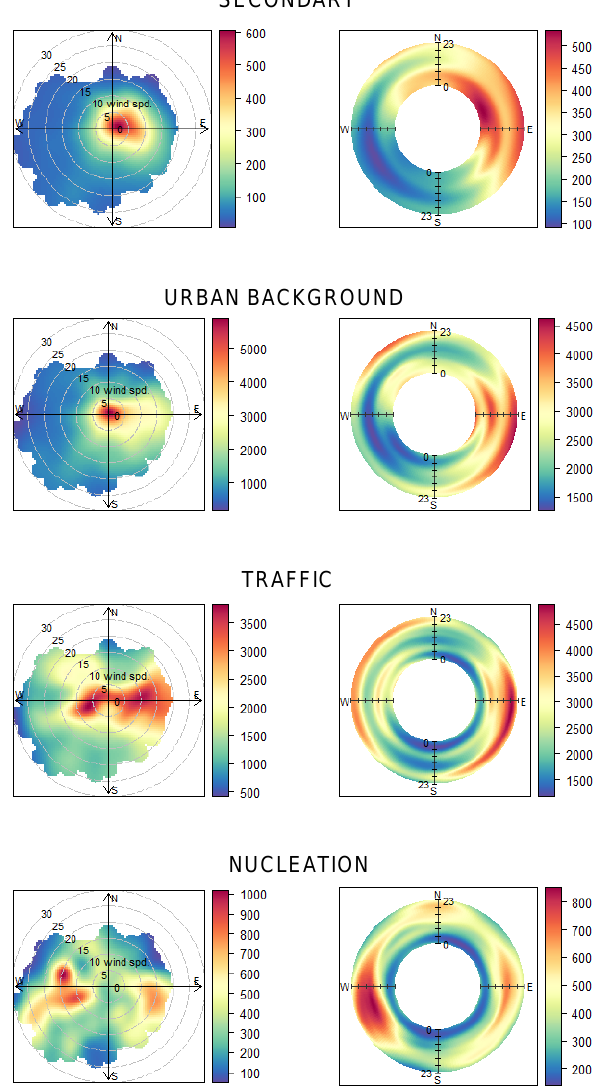
Figure 5. Polar plots showing how the hourly NSD contributions are affected by the hourly wind direction and wind velocity (units: NSD (cm − 3 ) and wind speed (ms − 1 )